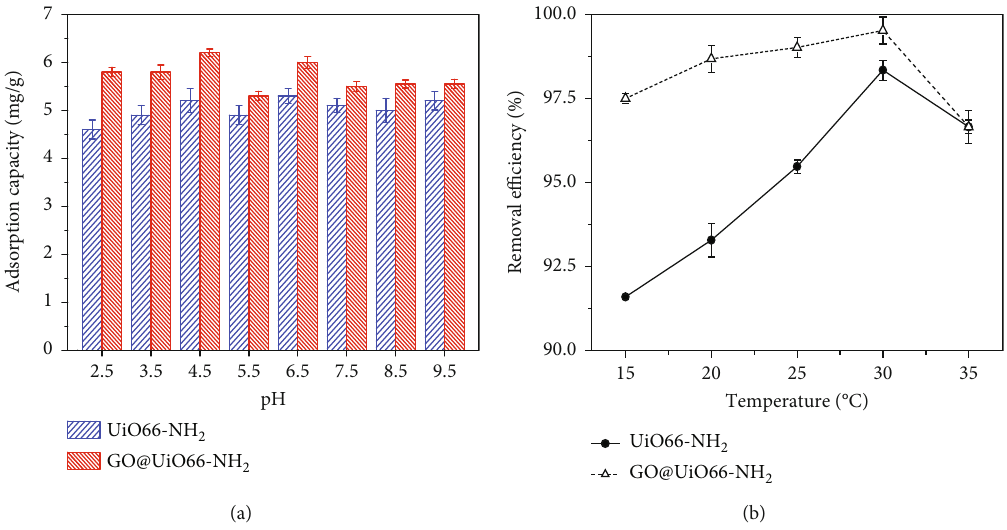
Figure 3: The e ff ect of pH (a) and temperature (b) on the adsorption of Sb (III) by UiO-66-NH